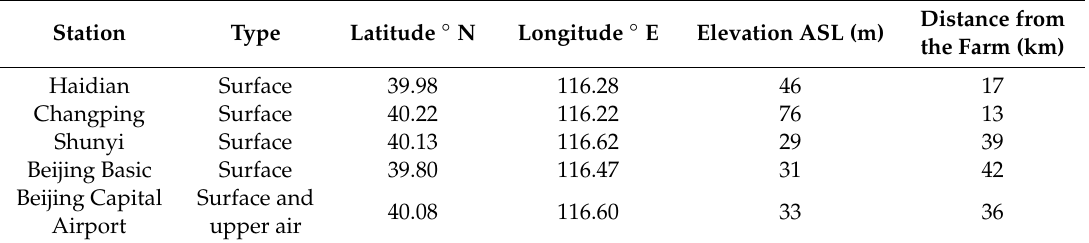
Table 2. Information on the meteorological stations examined in this study (data period: